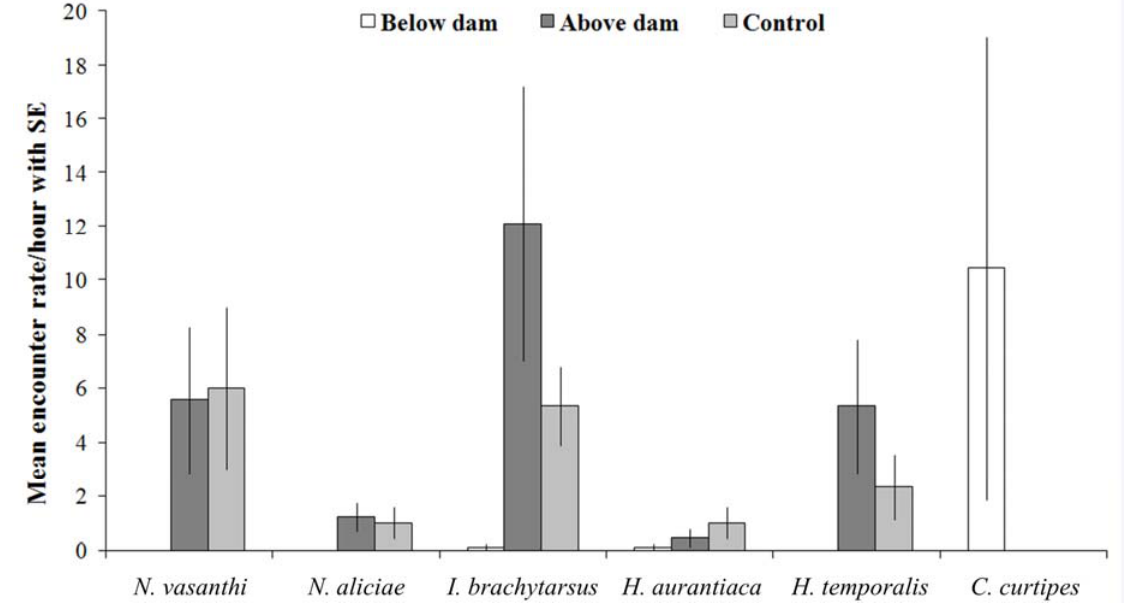
Figure 2. Mean number of individuals of the six species seen (with the standard errors) in below-dam, above-dam and in control sites.